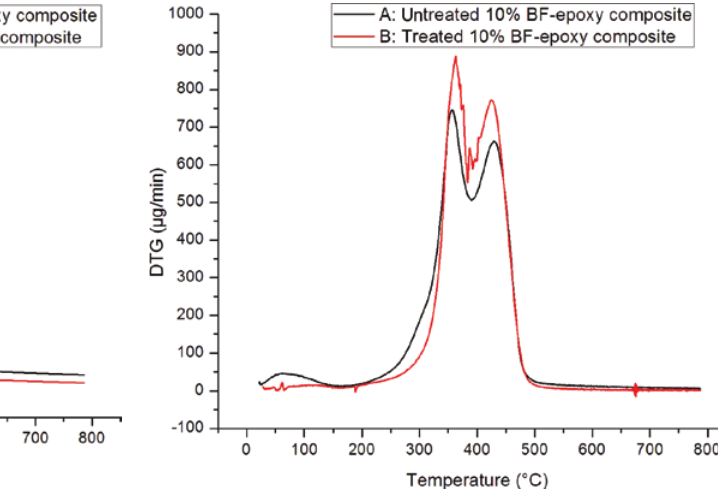
Figure 5: TGA thermogram of untreated and treated 40% BF-epoxy composites.